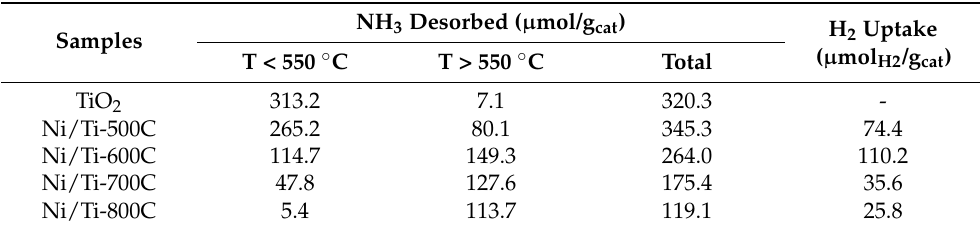
Figure 3. H 2 -TPR ( A ) and N 2 adsorption – desorption isotherms ( B ) profiles of the catalysts. Table 2. NH 3 desorbed and H 2 uptake of